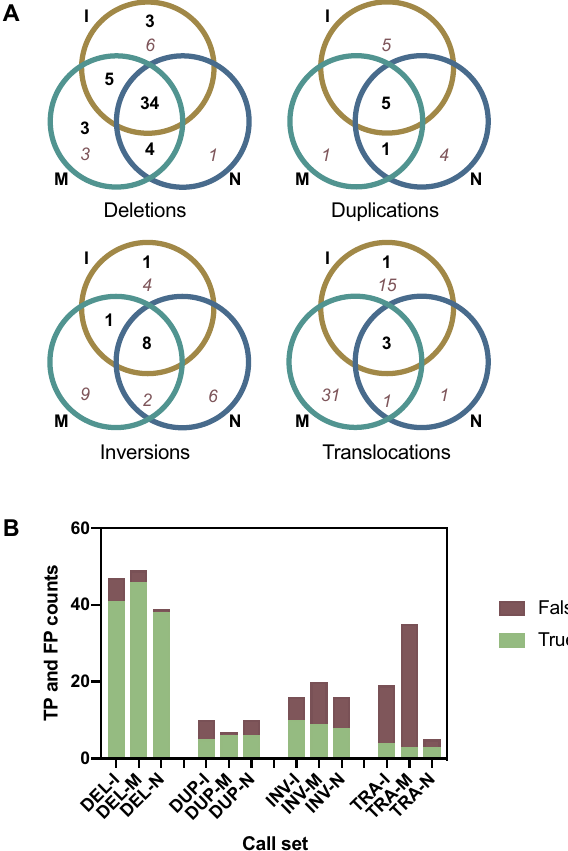
Figure 2. Large (> 10 kb), somatic structural variant calls obtained via different methods. ( A ) Venn diagrams showing overlap between calls obtained from Illumina short-read data (I; ochre), Nanopore long-read data mapped with minimap2 (M; turquoise) and Nanopore long-read data mapped with ngmlr (N; blue). Bold, black numbers represent true positive calls, while italic, dark red numbers represent false positive calls. ( B ) Data as above for ( A ), but shown as total counts for each method in a bar chart. Calls are grouped into deletions (DEL), duplications (DUP), inversions (INV) and translocations (TRA). True positive (TP) calls are shown in green and false positive (FP) calls are shown in